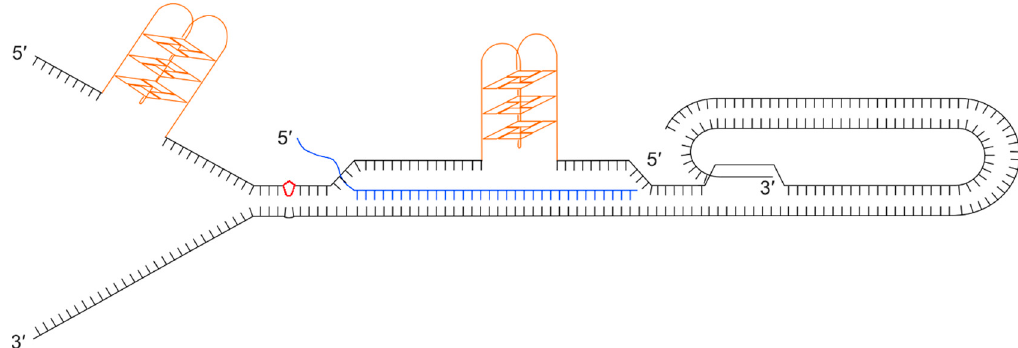
Figure 4. Illustration showing a collection of secondary structures that could impede progression of the replication fork through a telomere. Black lines show the double stranded telomeric DNA with a terminal t ‐ loop and D ‐ loop, as a result of the 3’ single stranded overhang invading the upstream duplex DNA. Orange structures show G ‐ quadruplexes on the (TTAGGG) n strand that could form during passage of the replication fork or when the G ‐ rich strand is displaced. The diagram also illustrates the formation of a DNA:RNA hybrid between the telomeric C ‐ rich strand and a telomere repeat ‐ containing RNA (TERRA) molecule (blue). The red kite shape shows damaged bases, for example a pyrimidine dimer.